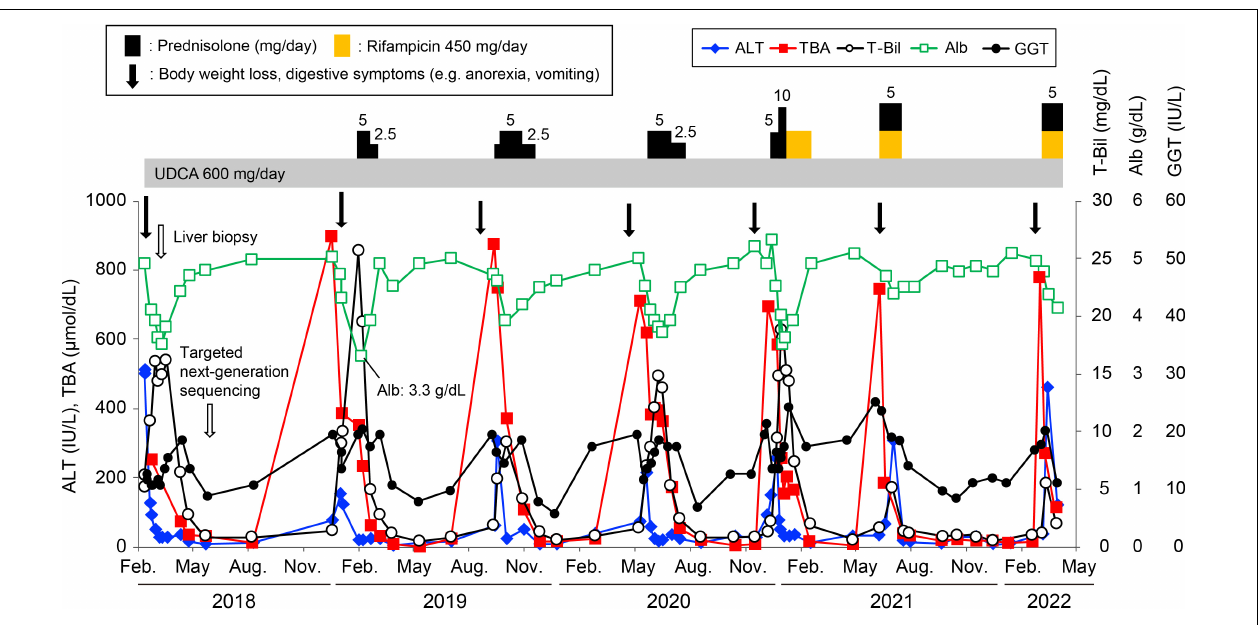
FIGURE 2 | Clinical course of the patient. Changes in serum alanine aminotransferase (ALT, (cid:117) ), total bile acid (TBA, (cid:4) ), total bilirubin (T-Bil, gamma-glutamyl transpeptidase (GGT, ) levels. The patient was treated with prednisolone or rifampicin with ursodeoxycholic acid during the attacks. The lowest albumin level during the follow-up period was 3.3 (cid:32)